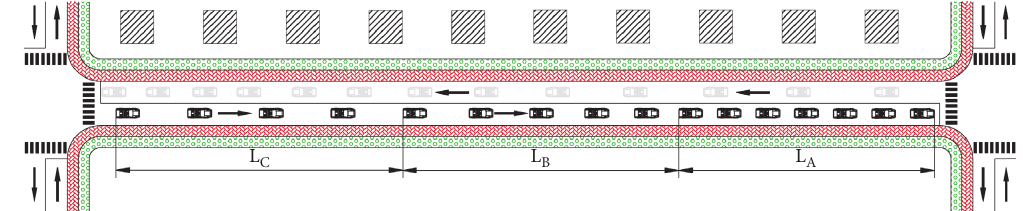
Figure 1: Traffic flow operation on the downstream queuing